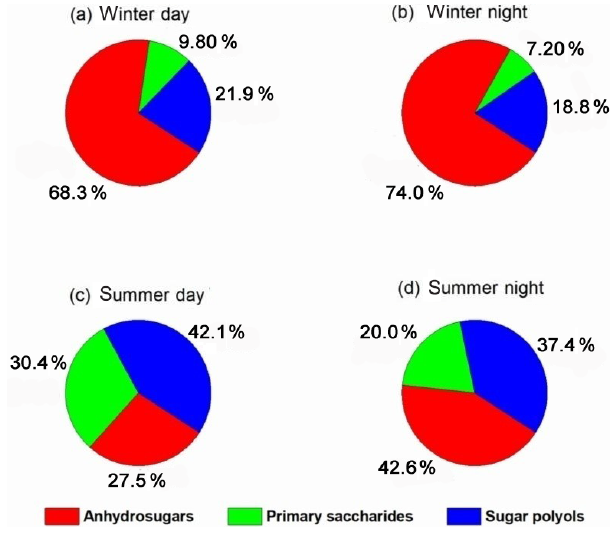
Figure 10. Relative contributions of anhydrosugars, primary sac- charides, and sugar polyols during the day- and night-time in winter and